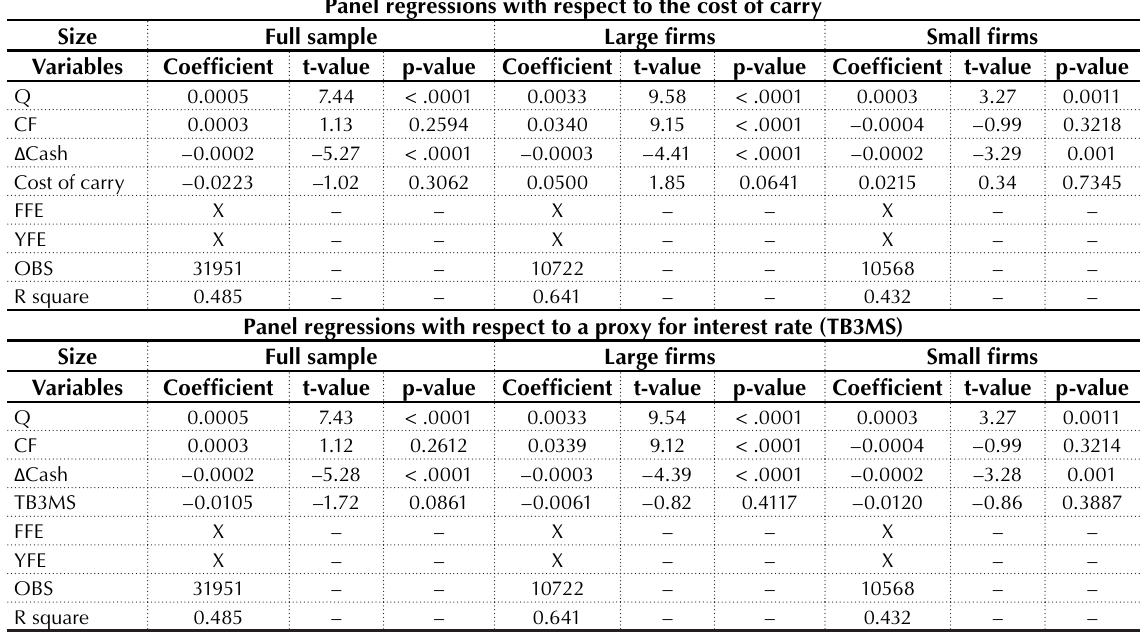
Table 5. Panel regressions of corporate investment Panel regressions with respect to the cost of